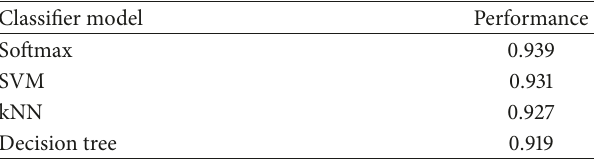
Table 6: The effect of different classifier algorithms.